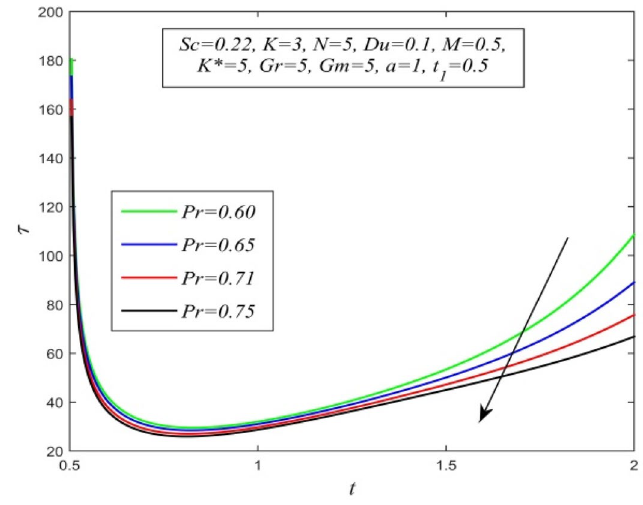
Figure 35. τ versus t for different Pr and Sc = 0.22, K = 3, N = 5, M = 0.5, Du = 0.1, K* = 5, Gr = 5, Gm = 5, a = 1, t 1 = 0.5.